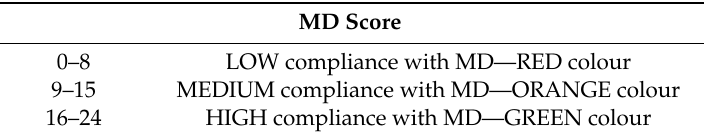
Table 5. Levels of MD adherence